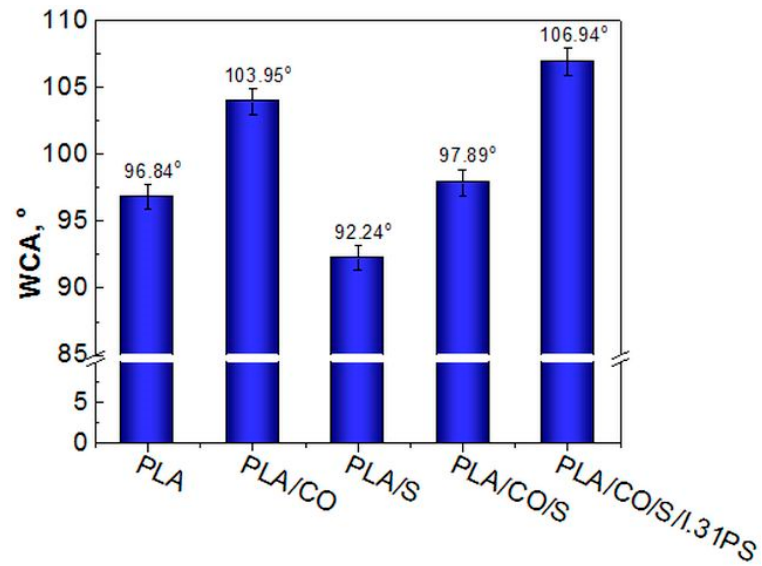
Figure 2. Water contact angle for the neat PLA and the PLA-based biocomposites.